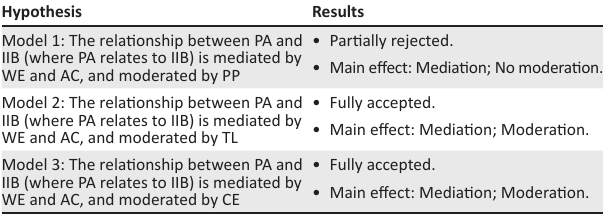
TABLE 2: Summary of the hypothesised